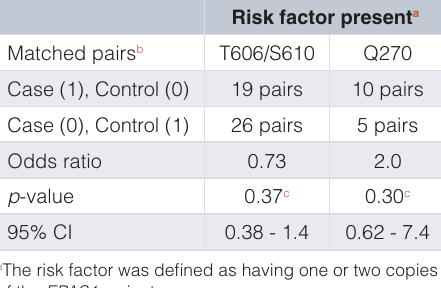
Table 4. McNemar’s test with EPAS1 T606/S610 and Q270